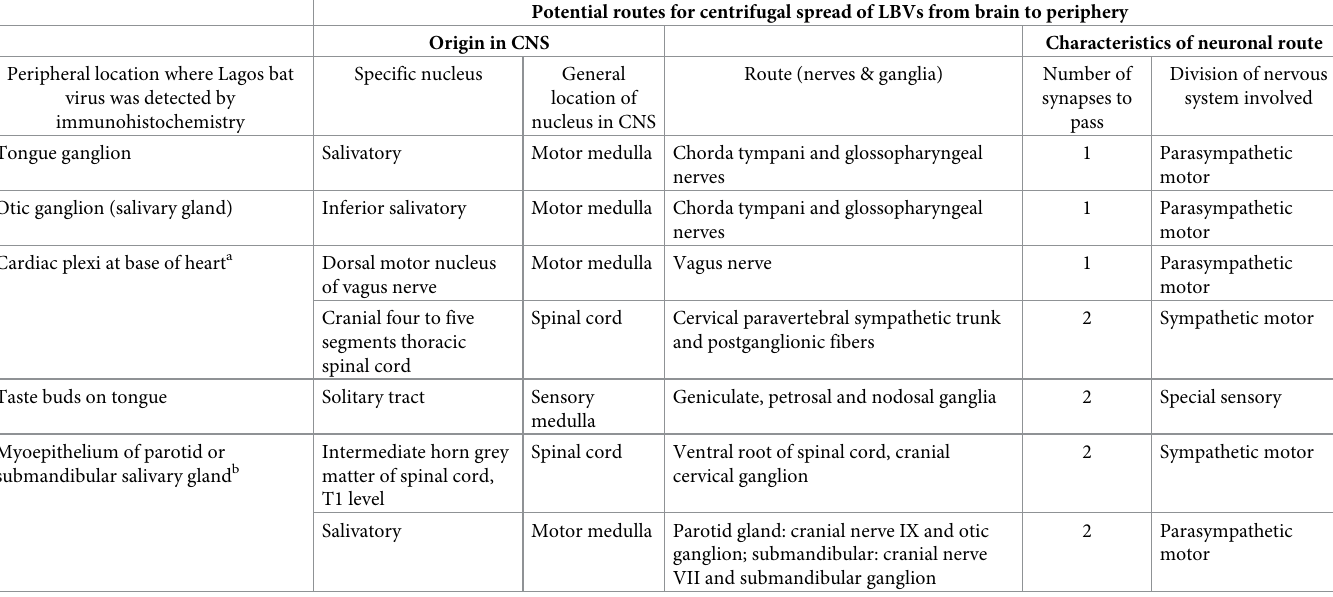
Table 6. Possible neuronal routes of spread of Lagos bat virus from the brain to the periphery (centrifugal spread). Potential routes for centrifugal spread of LBVs from brain to